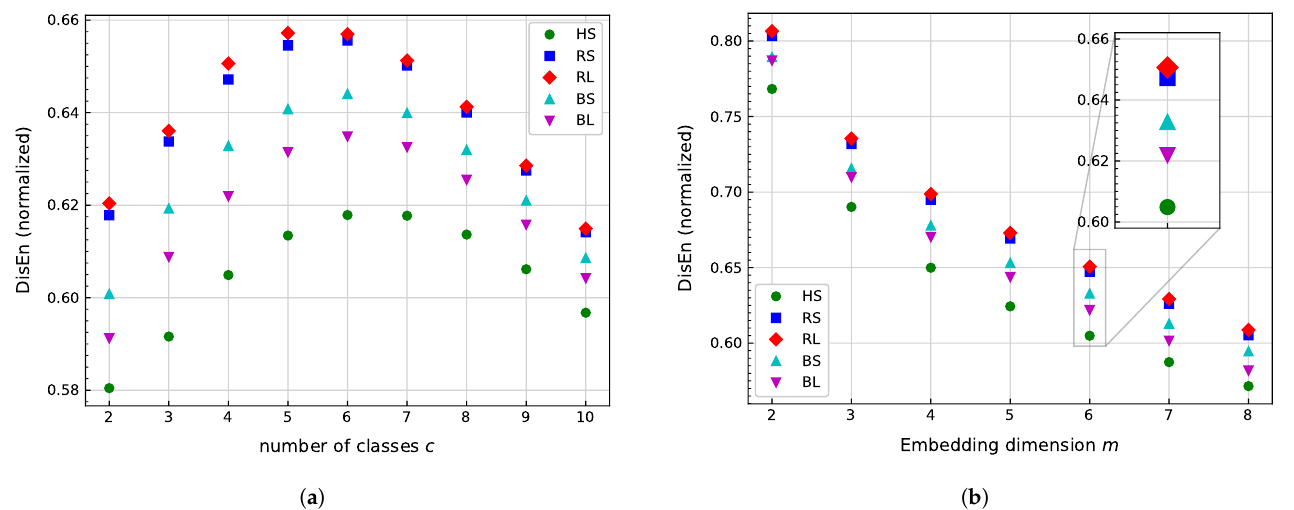
Figure 10. Comparison of dispersion entropy (DisEn) mean value for several bearing signals at same rotational speed, with fixed W s = 10,240. ( a ) Values for fixed m = 6, varying c . ( b ) Values for fixed c = 4, varying m